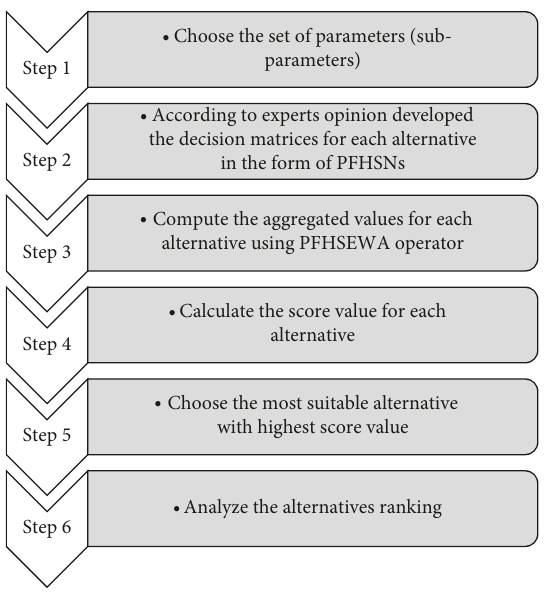
Figure 1: Flowchart of the proposed